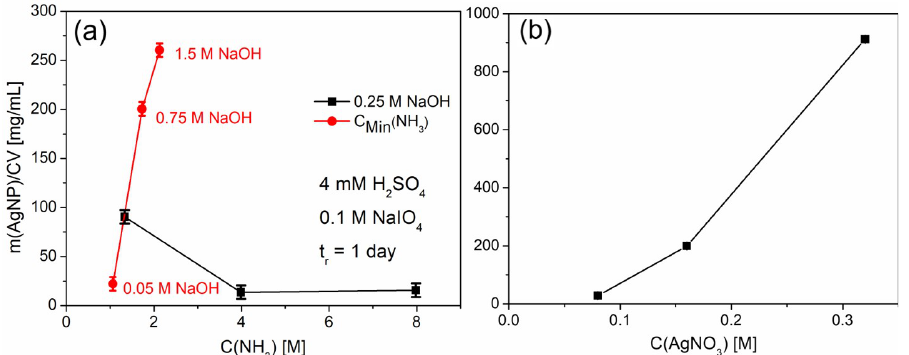
Figure 3. ( a ) Influence of NH 3 and NaOH concentrations on the quantity of AgNPs. Black squares represent conditions with a constant NaOH concentration and red dots represent conditions with a minimal concentration of NH 3 at various NaOH concentrations (written next to the data points) needed to dissolve the Ag 2 O precipitate. The maximal theoretical m(AgNP)/CV was ≈ 690 mg/mL and the reaction time was 1 day. ( b ) Influence of AgNO 3 concentration on the quantity of AgNPs after 5 days of reaction